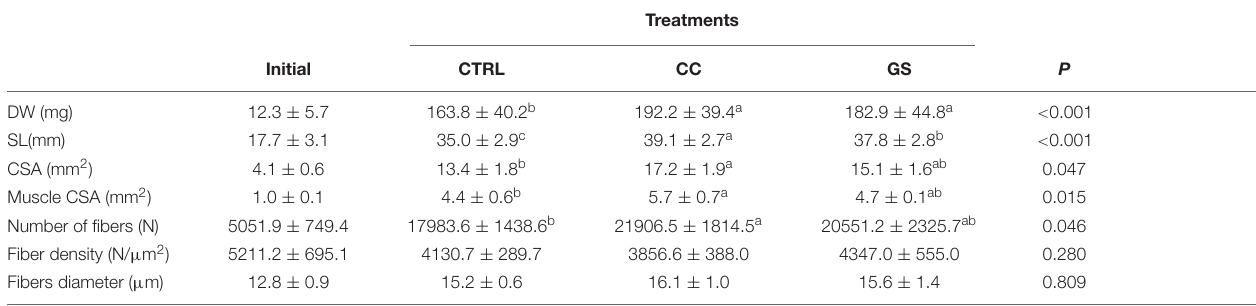
TABLE 3 | Growth performance and muscle cellularity parameters of Senegalese sole post-postlarvae at the beginning (45 DAH) and the end of the growth trial (70 DAH).